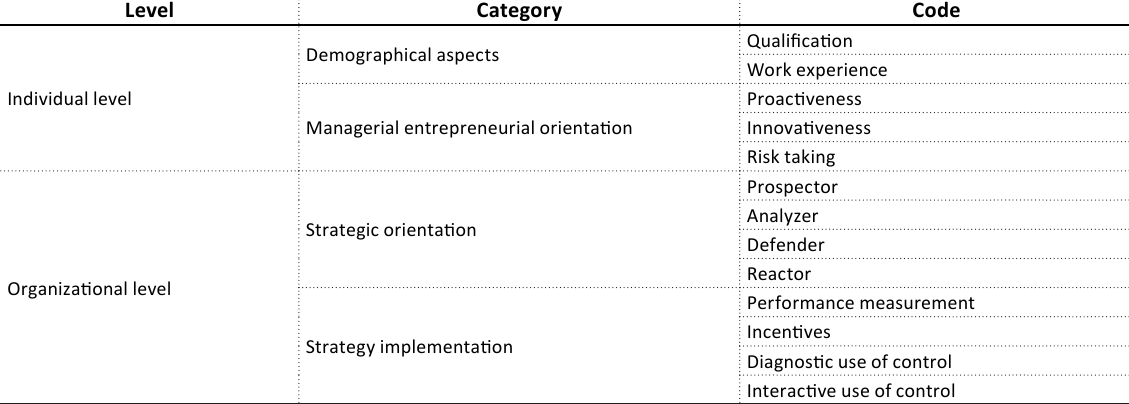
Table A2. List of deductive codes